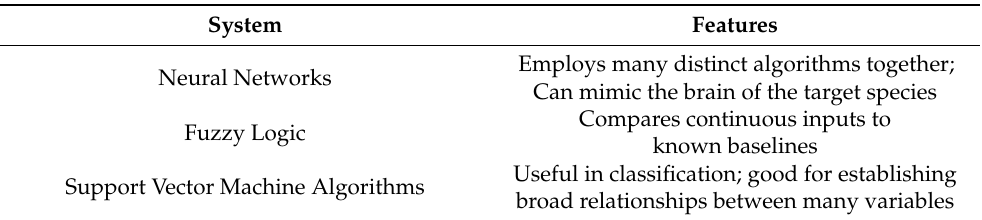
Table 3. Key features of machine learning algorithm